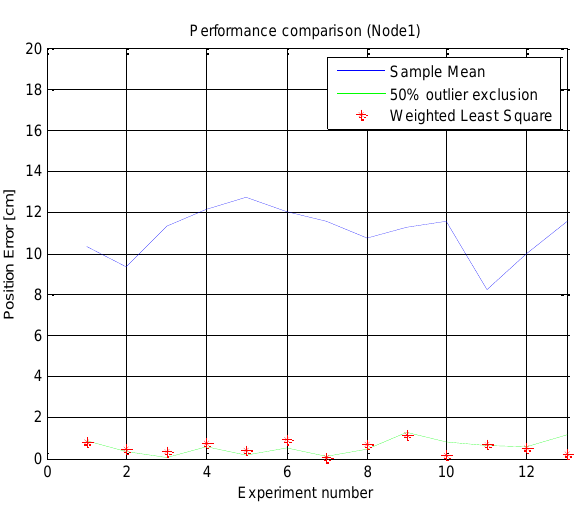
Figure 17. Position error of the repeated tests with the error reduction methods for the MEMS